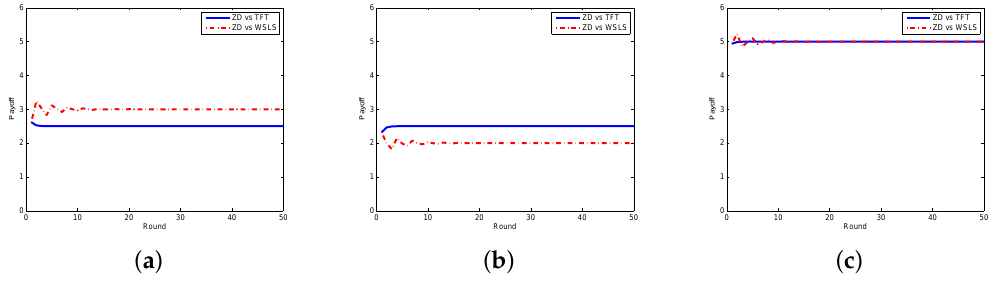
Figure 5. Payoffs with ZD vs. TFT/WSLS in the discrete model. ( a ) requestor’s payoff; ( b ) worker’s payoff; ( c ) social